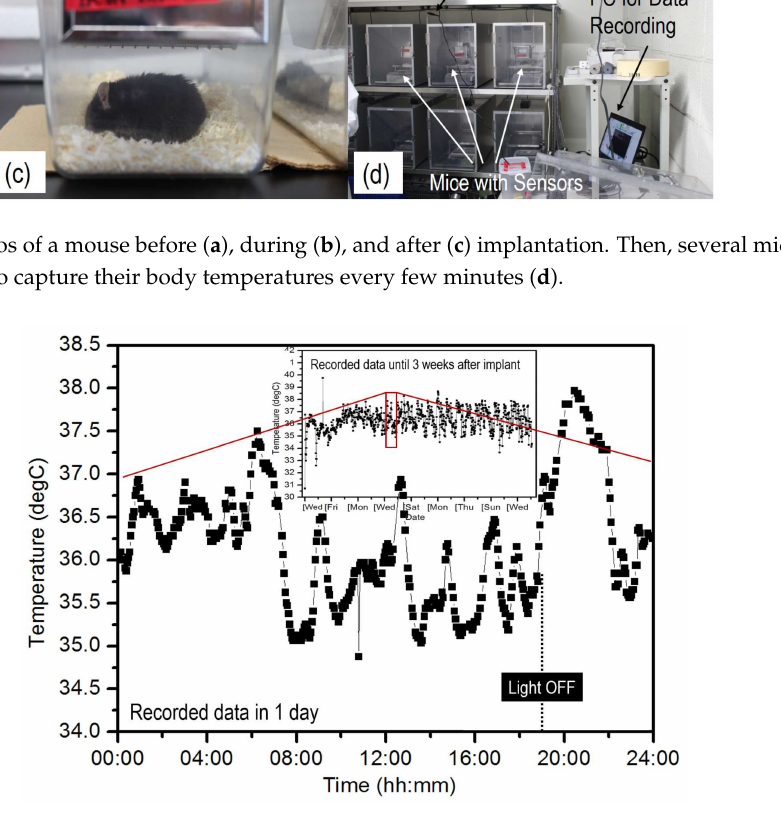
Figure 4. Recorded body temperature of a mouse in a day. The inset is the data for the three weeks directly following the